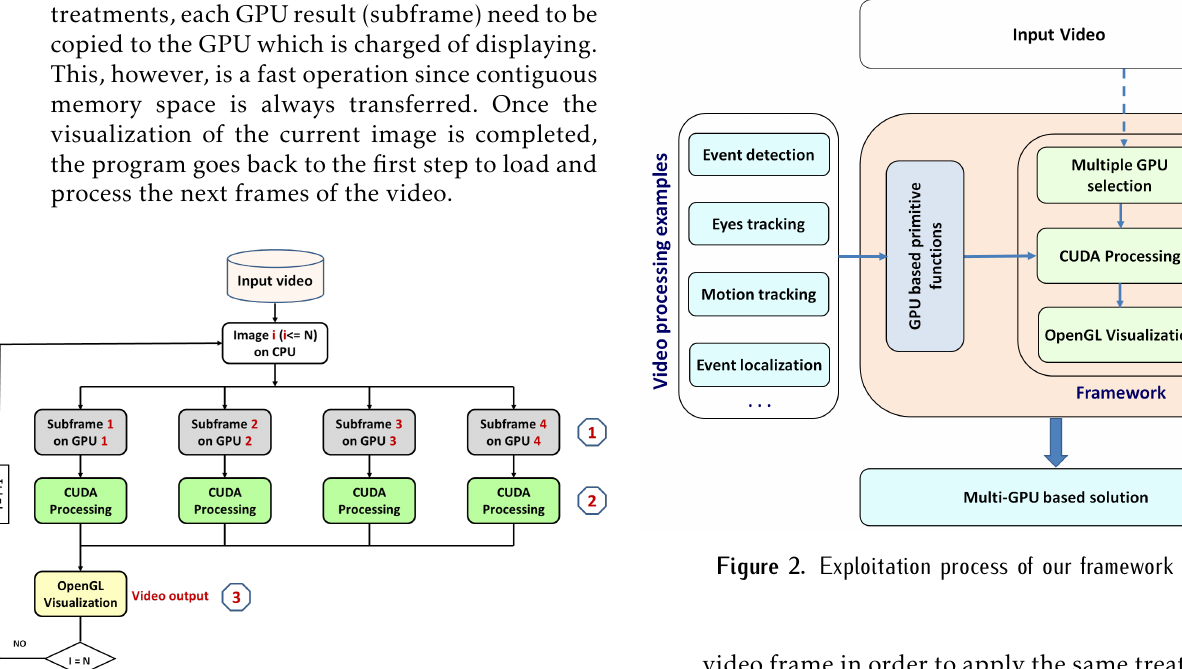
video frame in order to apply the same